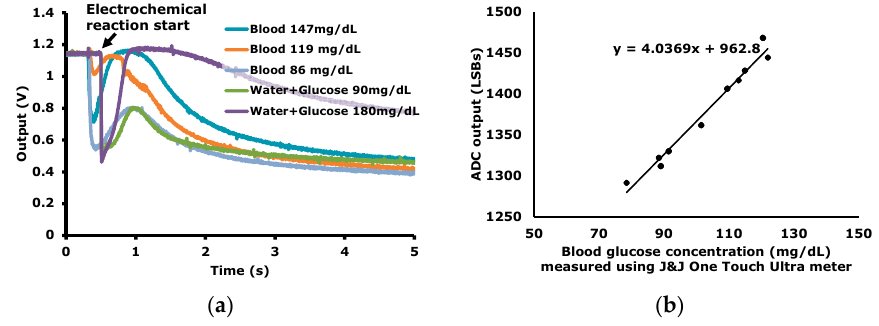
Figure 12. Blood glucose measurement results in EC mode; ( a ) time-domain electro-chemical reaction signal; ( b ) ADC output vs. blood glucose concentration.